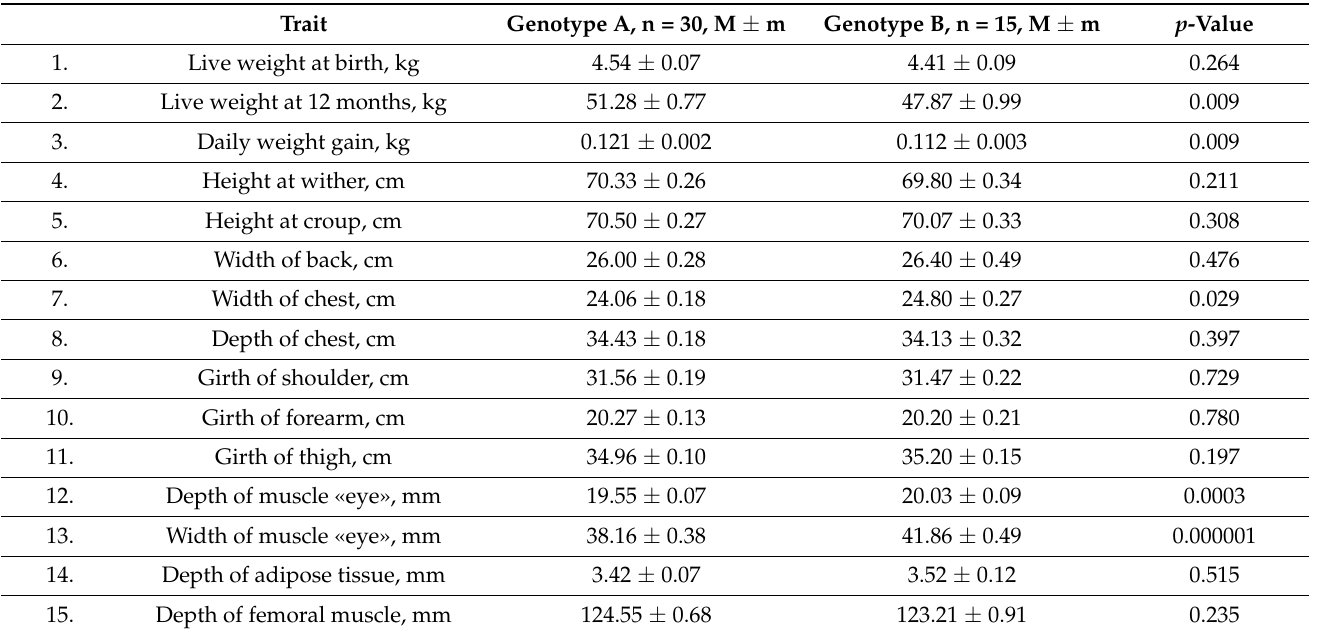
Table 3. Body measurements of Jalgin merino with different genotypes.